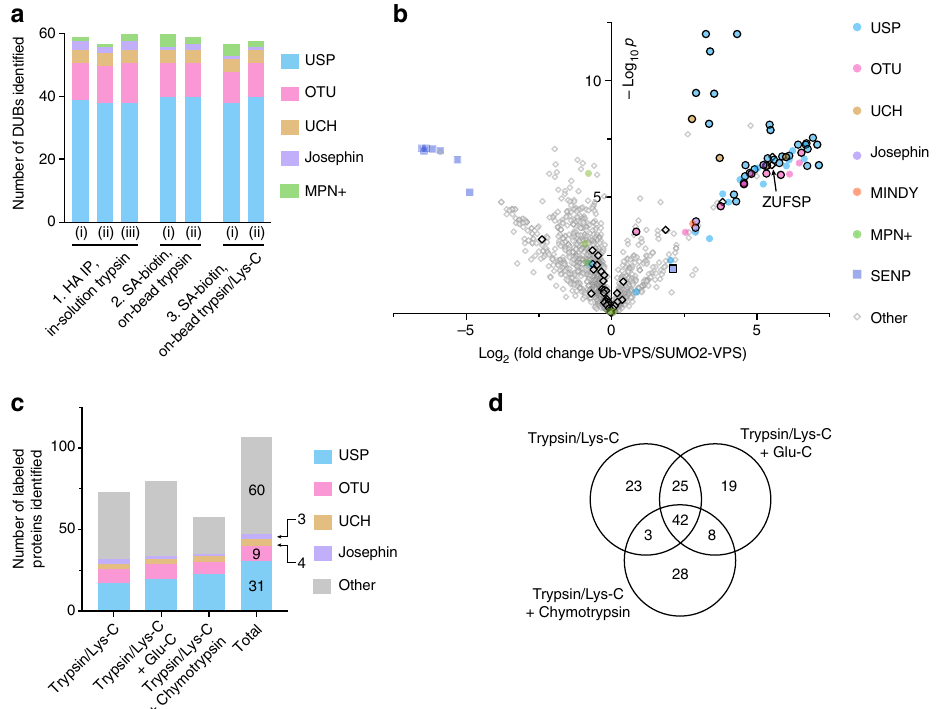
Fig. 3 A reactive-site-centric chemoproteomic method to identify probe-labeling sites. a Comparison of the number of DUBs identi fi ed by different puri fi cation or digestion methods. HEK 293T lysate was treated with Ub-VS (condition 1) or Ub-VPS (conditions 2 and 3), and then subject to anti-HA IP followed by FASP using trypsin (condition 1) or tagged with biotin-DADPS-azide, enriched on streptavidin (SA) beads, and digested on-bead with trypsin (condition 2) or Lys-C and trypsin (condition 3). Shown is the number of DUBs identi fi ed with ≥ 3 unique peptides, in each of two or three biological replicates (indicated with Roman numerals). b Volcano plot of pairwise comparison of proteins in on-bead digestion fraction from ABPP using Ub-VPS probe and SUMO2-VPS probe. Statistical signi fi cance ( − log 10 p -value) is plotted against fold enrichment (average log 2 ) from three biological replicates. A black border indicates proteins with high-con fi dence probe-labeling sites (i.e., sites identi fi ed in more than one experiment). ZUFSP is indicated with an arrow. c Comparison of the number of labeled proteins identi fi ed after cleavage of DADPS linker using different combinations of proteases. Shown is the number of proteins for which one or more labeled peptides were detected in any one of six biological replicates. Each replicate corresponds to a nominal protein input of 3 mg. d Venn diagram showing the intersections of probe-labeling sites identi fi ed using different combinations of proteases. Diagram produced using Venny 2.1